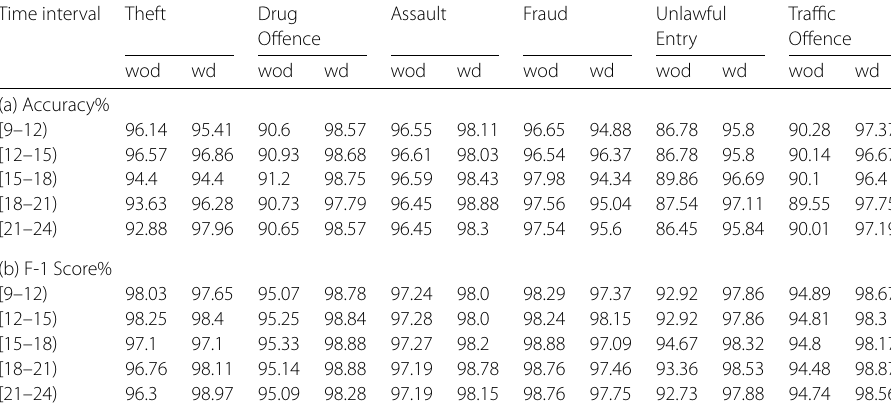
Table 5 Metrics comparison with and without dynamic features for Brisbane (“wod” and “wd” represent without and with dynamic features respectively) Time interval